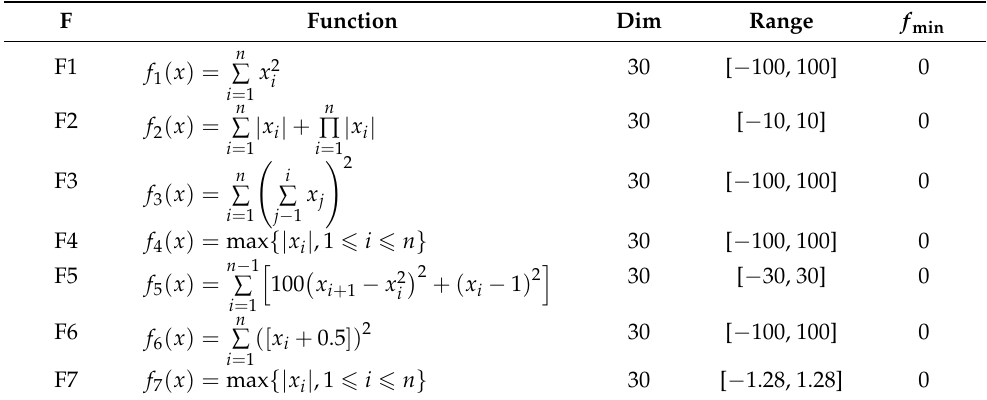
Table 2. Unimodal benchmark functions.